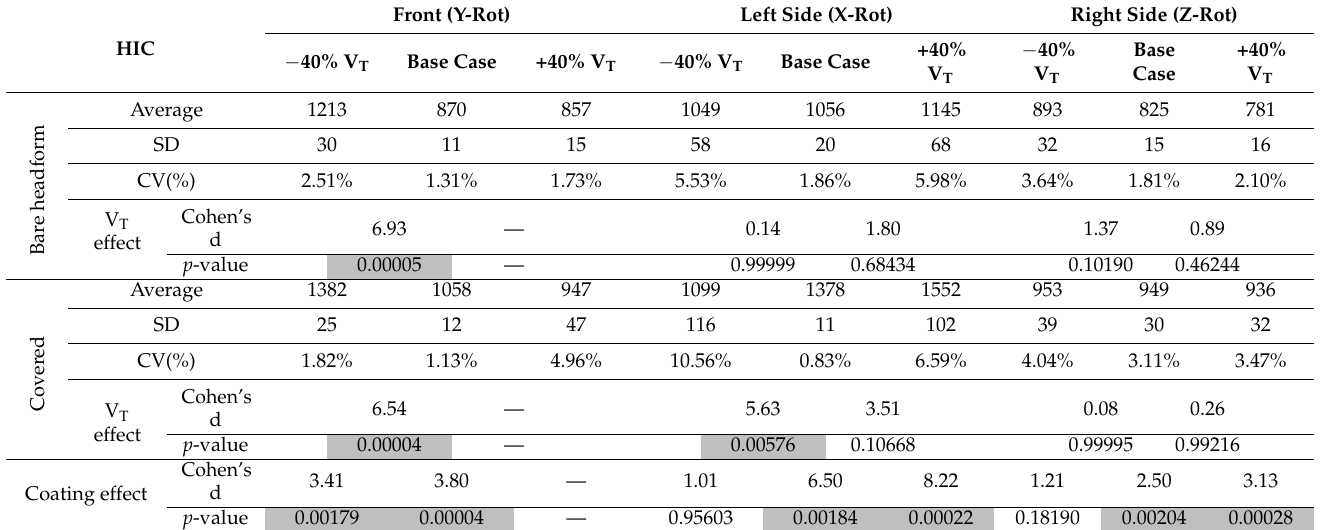
Table 5. Averages, standard deviation (SD), coefficient of variation (CV) and post-hoc results for HIC. p -values < 0.05 portrayed as shaded cells.